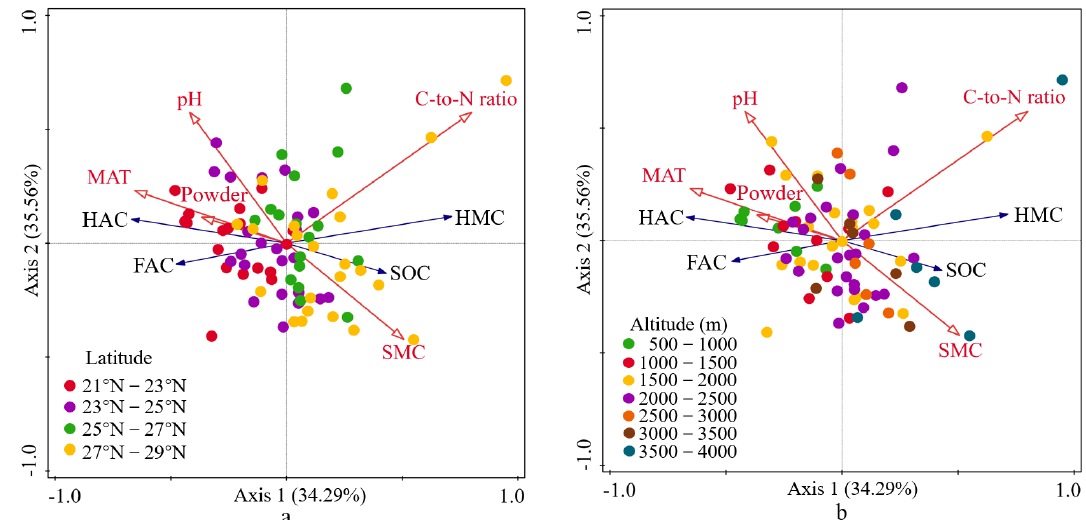
Figure 5. RDA ordination of soil organic matter composition and environmental factors. Figure ( a ) represents RDA ordination at different latitudes; Figure ( b ) represents RDA ordination at different altitudes. FAC, fulvic acid carbon; HAC, humus acid carbon; HMC, humin carbon; MAT, mean annual temperature; RDA, redundancy analysis; SMC, soil moisture content; SOC, soil organic carbon.